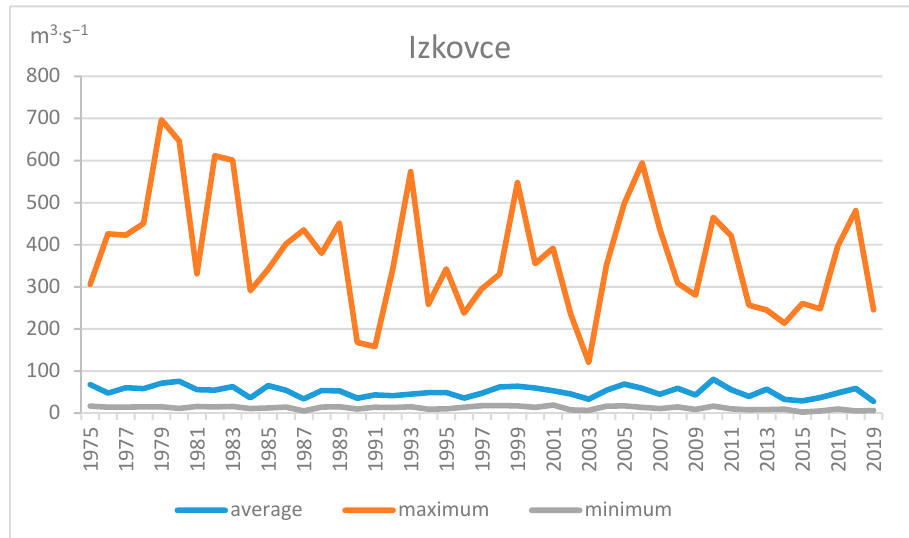
Figure 4. Average, maximum, and minimum flows of the Laborec River at Izkovce gauging station in the hydrological years 1975–2019.